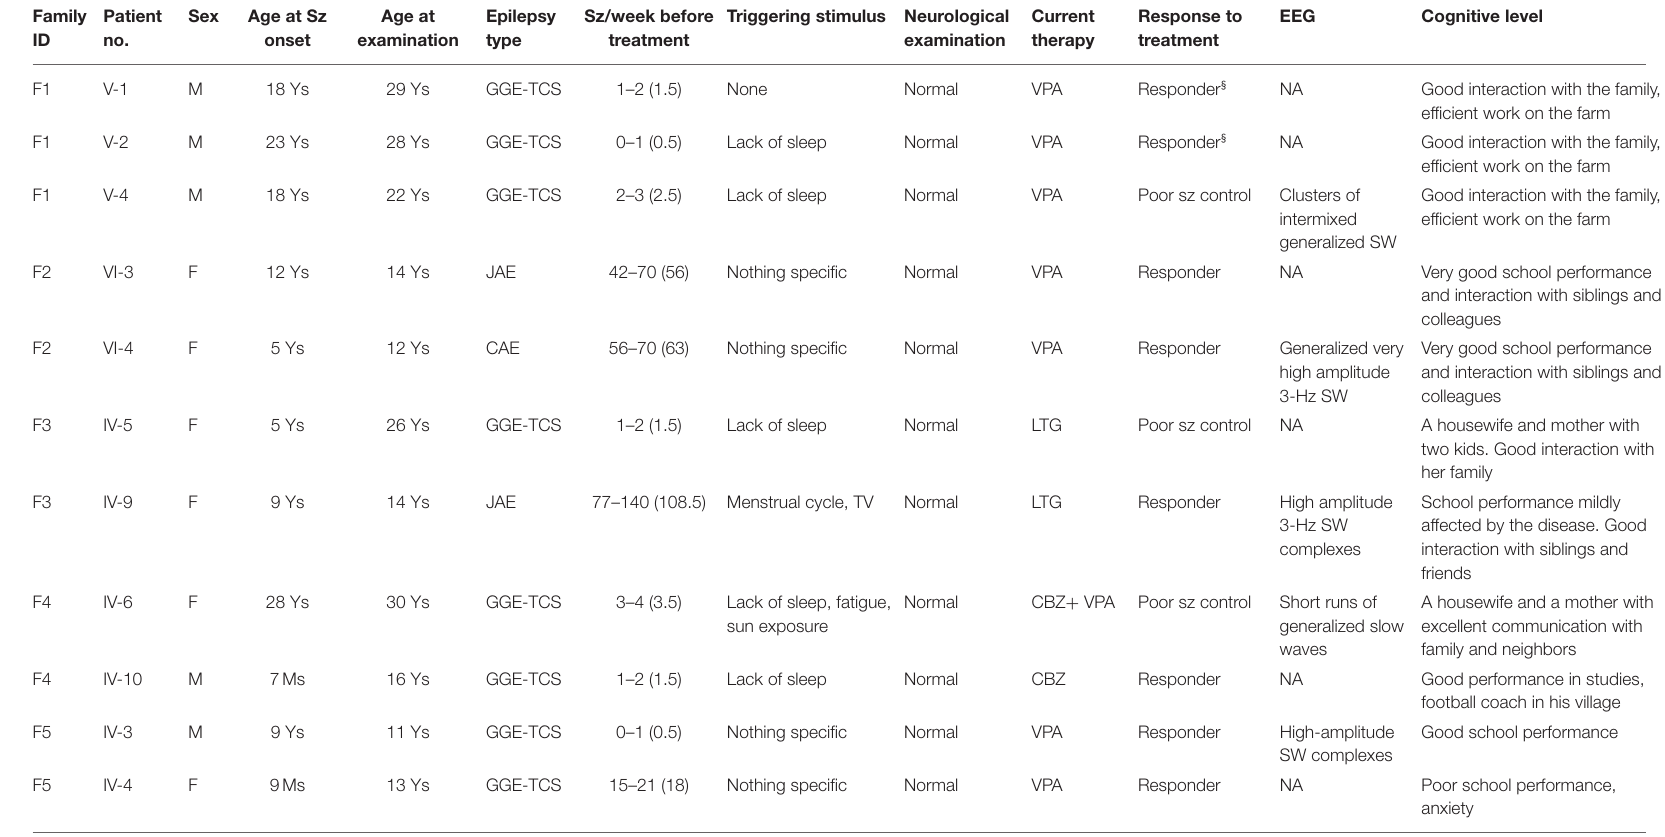
TABLE 2 | Clinical data of the patients. Family Patient ID